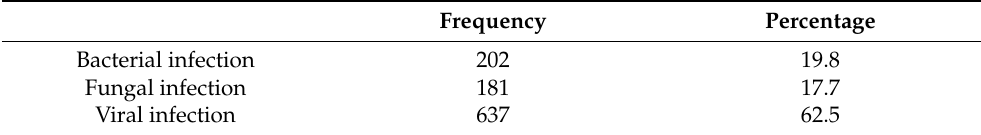
Table 3. Public perceptions regarding the types of monkeypox disease (bacterial, fungal, viral).